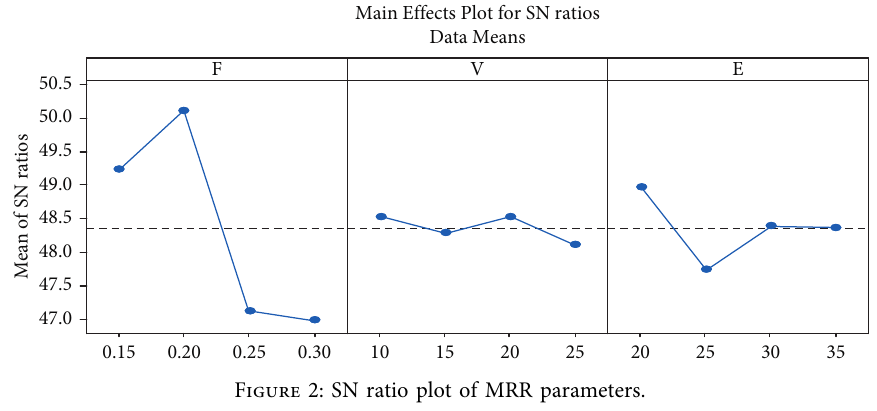
Figure 2: SN ratio plot of MRR